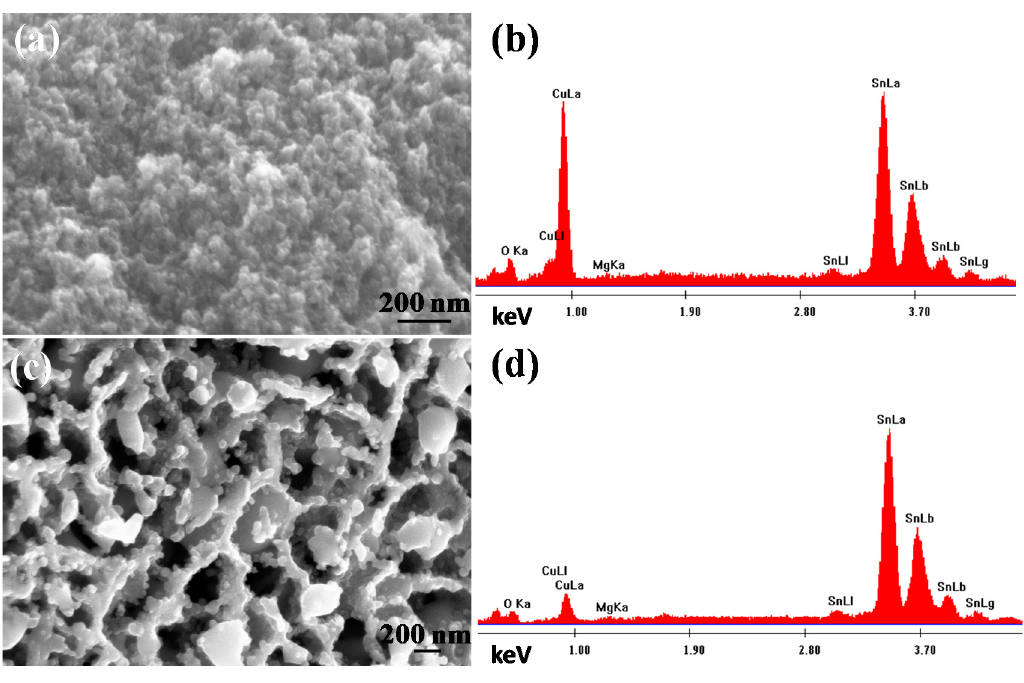
Figure 2. The SEM images and corresponding EDS spectra of ( a , b ) Mg 67 Cu 18 Sn 15 and ( c , d ) Mg 66 Cu 10.2 Sn 23.8 after dealloying in 1 wt.% TA.